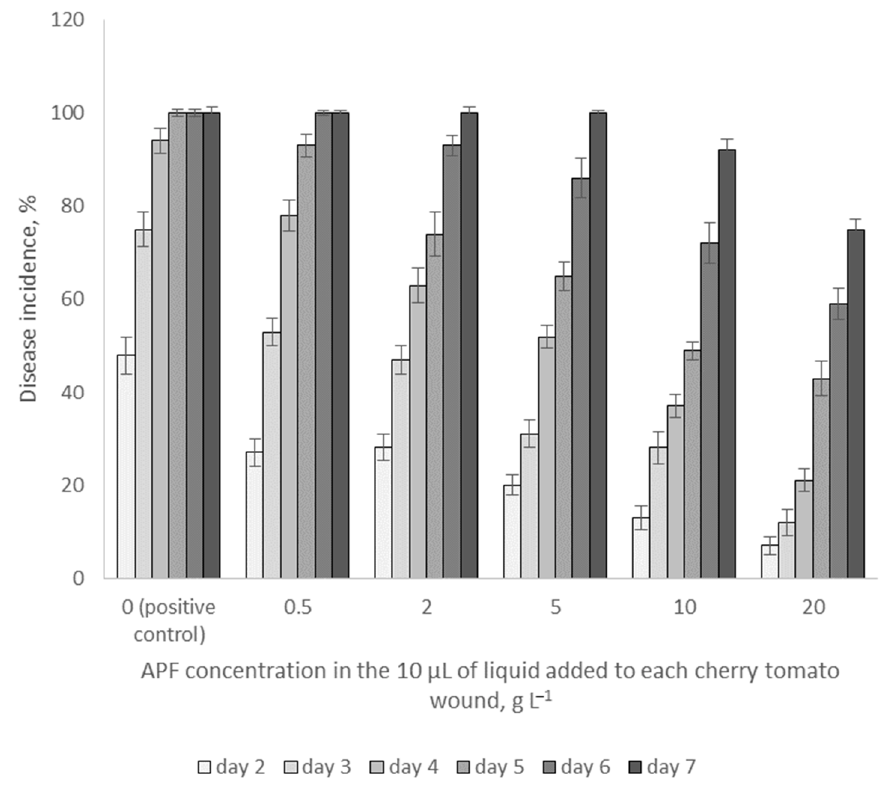
Figure 5. Disease incidence of cherry tomato fruits treated with F. oxysporum (positive control) and lipopeptides produced by B. mojavensis P1709 at different concentrations, revealed 2–7 days after inoculation. The Wilcoxon signed rank test was used to determine statistically significant differences ( p < 0.05); the results of determination are presented in Supplementary Material.